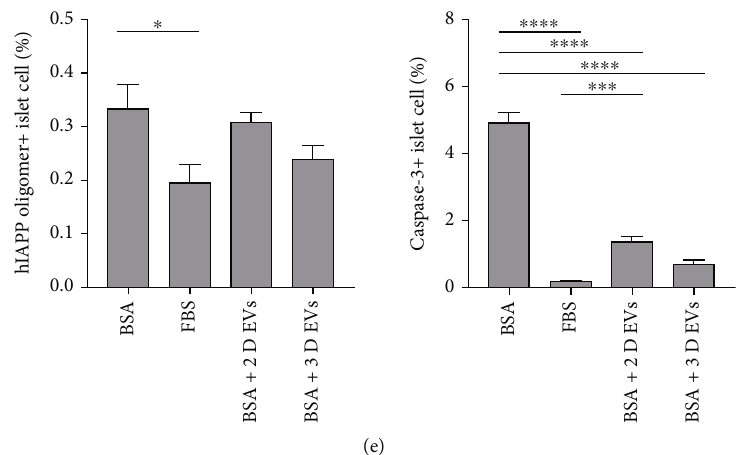
Figure 7: E ff ect of 3D hUCB-MSC-derived EVs on the expression of β -cell identity markers in islets. The hIAPP +/- mouse islets were cultured under four conditions: medium supplemented with 10% fetal bovine serum (FBS group), medium supplemented with 0.625% bovine serum albumin (BSA group), 20 μ g/mL 2D hUCB-MSC-derived EVs plus 0.625% BSA (BSA +2D EV group), and 20 μ g/mL 3D hUCB-MSC-derived EVs plus 0.625% BSA (BSA +3D EV group). (a) Concentrations of Oct4, NGN3, Pdx1, and FoxO1 in hIAPP +/- islet cells treated with EVs produced by 2D- or 3D-cultured hUCB-MSCs were measured using qRT-PCR. The error bars represent the standard deviation of measurements in three separate sample runs ( n = 9 ). (b) Immunocytochemical staining with antibodies against insulin (red); DAPI (blue); and Oct4, NGN3, Pdx1, and FoxO1 (green). Scale bar = 100 μ m . (c) The percentage proportions of Oct4-, NGN3-, Pdx1-, and FoxO1-stained cells (green) among total DAPI-positive islet cells (blue; 50 ~ 100 islets per group). The error bars represent the standard deviation of measurements in three separate runs ( n = 12 ). (d) Immunocytochemical staining with antibodies against insulin (red), DAPI (blue), and hIAPP oligomer and cleaved caspase-3 (green). Scale bar = 100 μ m . (e) The percentage proportions of hIAPP oligomer and cleaved caspase-3-stained cells (green) among total DAPI-positive islet cells (blue; 50 ~ 100 islets per group). The error bars represent the standard deviation of measurements in three separate sample runs ( n = 12 ). Columns, mean; bars, SD. ∗ p < 0 : 05 , ∗∗ p < 0 : 005 , ∗∗∗ p < 0 : 0005 , and ∗∗∗∗ p < 0 : 0001 , by one-way ANOVA and Tukey ’ s